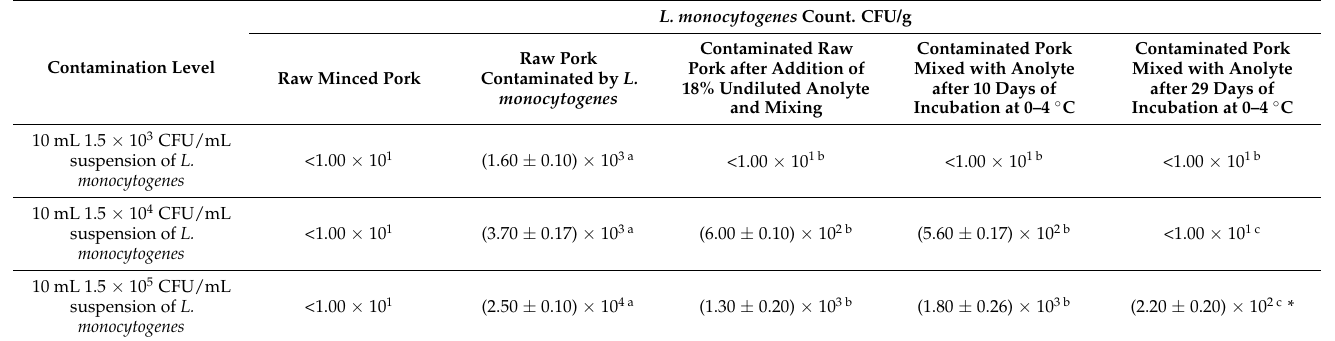
Table 6. Effect of anolyte on the L. monocytogenes count of minced pork contaminated by L. monocytogenes .